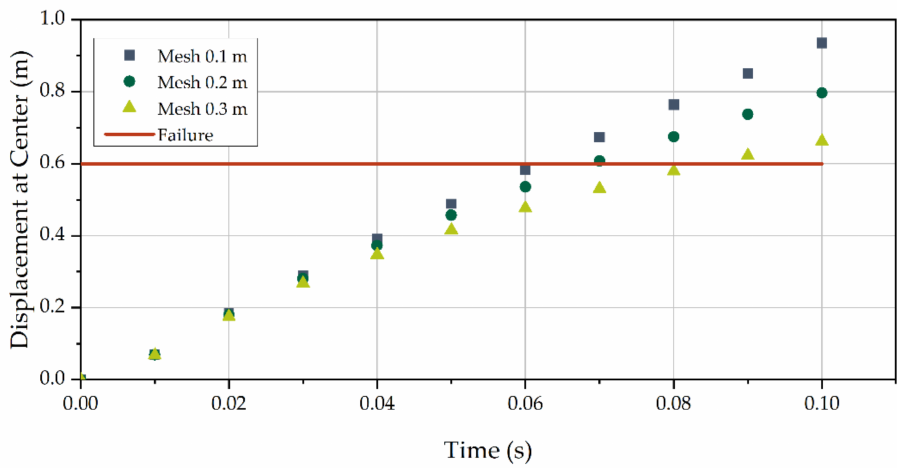
Figure 13. Displacement at the center of the wall over time.